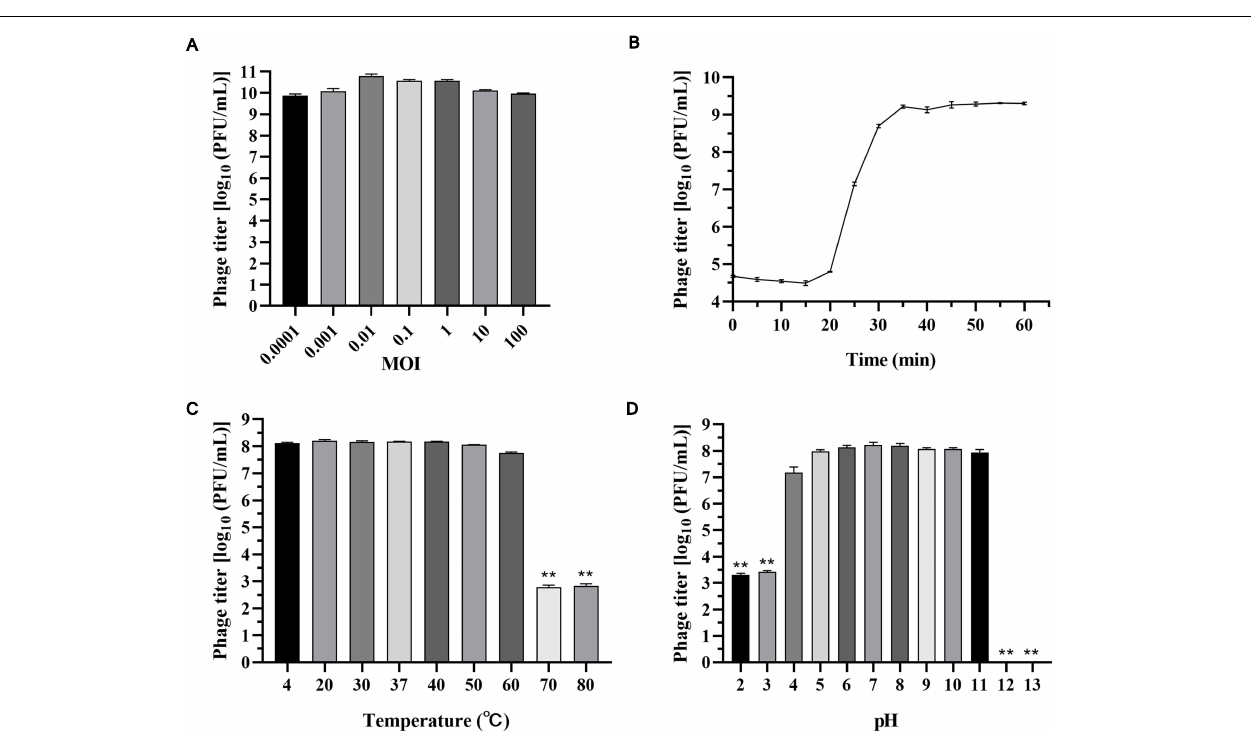
FIGURE 2 | Biological characteristics of Salmonella phage vB_SalP_TR2. (A) Phage titers were measured at different multiplicity of infection (MOIs) (0.0001 to 100). (B) The one-step growth curve of vB_SalP_TR2 using S. Albany as the host in LB medium at MOI of 0.01. (C) Temperature stability. Phages were incubated